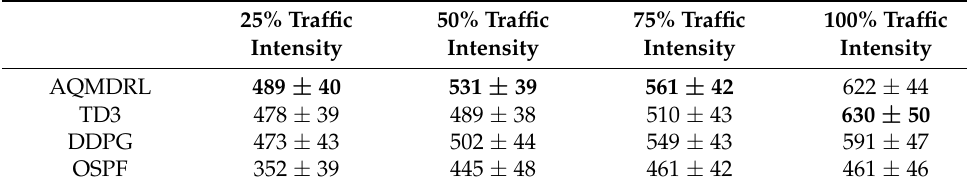
Table 2. Comparison of average link-delay coefficient in different traffic intensities.